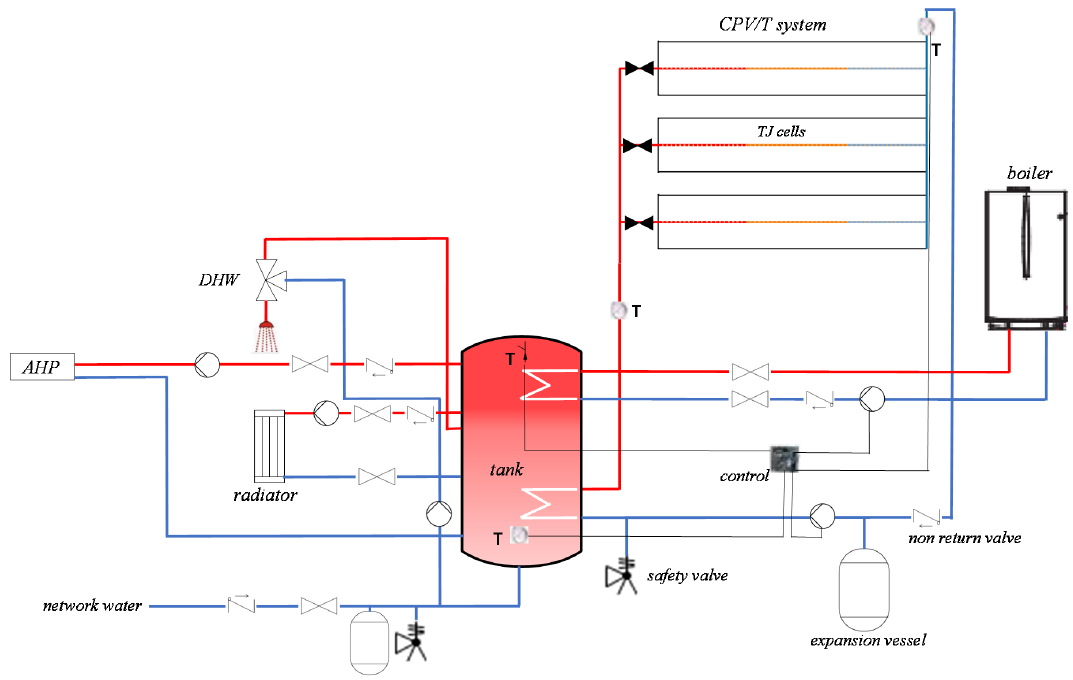
Figure 2. Scheme of the CPV/T system subjected to a residential user.